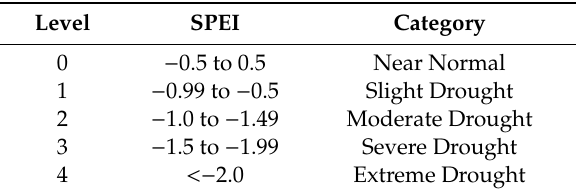
Table 1. The classification of SPEI.